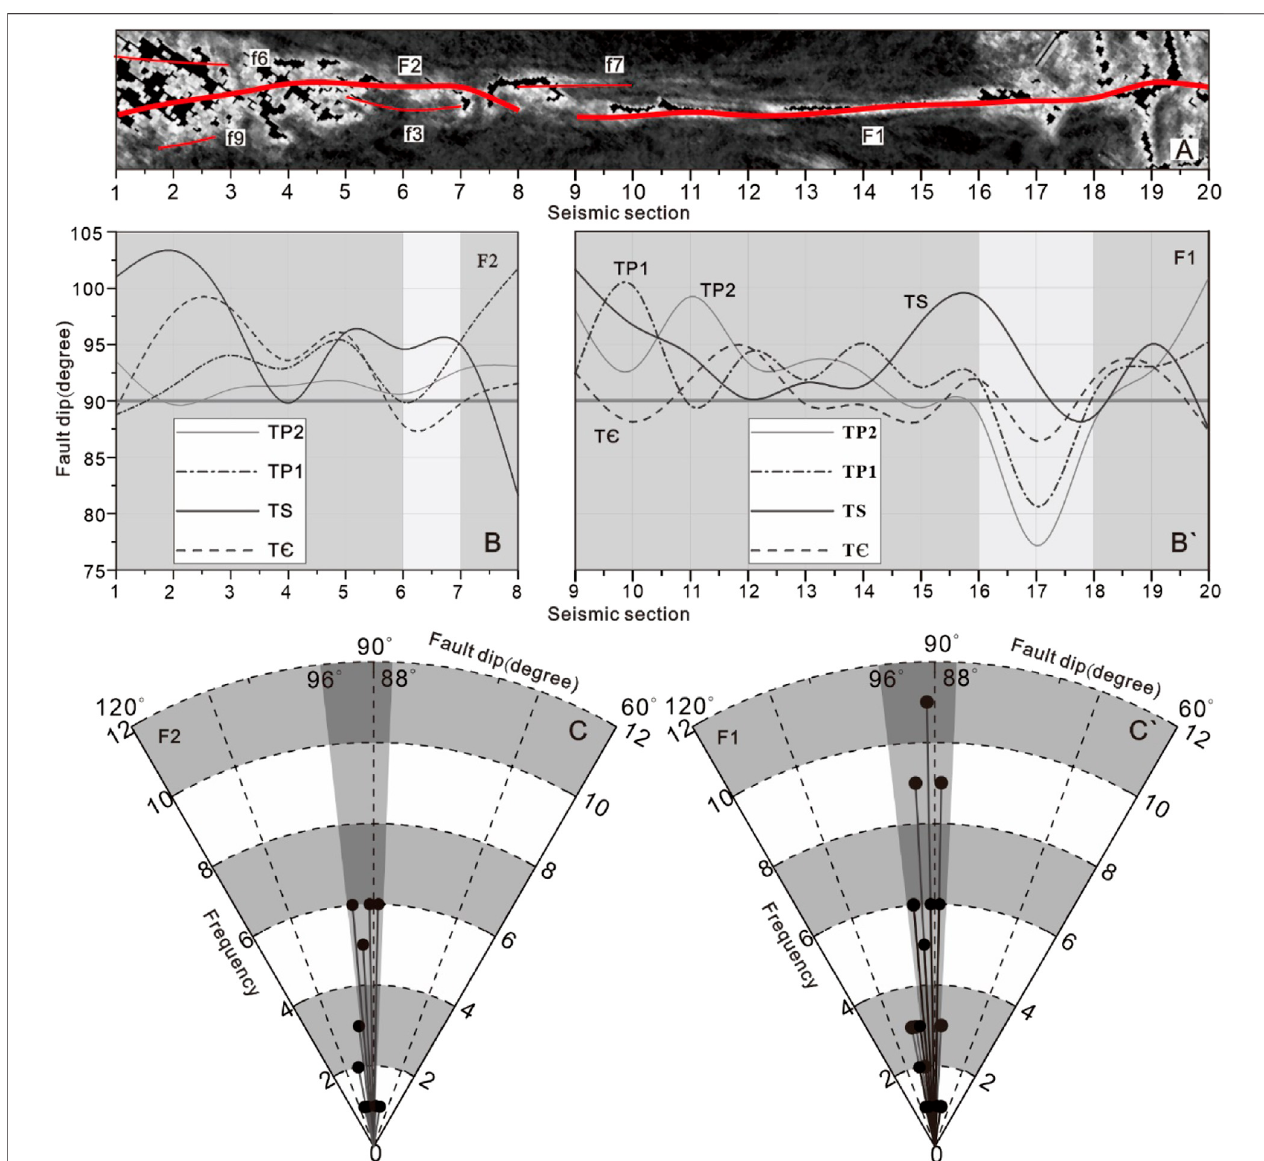
FIGURE9| (A) Planedistributionmapoffaultzone,LinechartofdipAnglevariationofmainfaultF2 (B) andF1 (B') andDipfrequencydistributiondiagramofF2 (C) and F1 (C') .